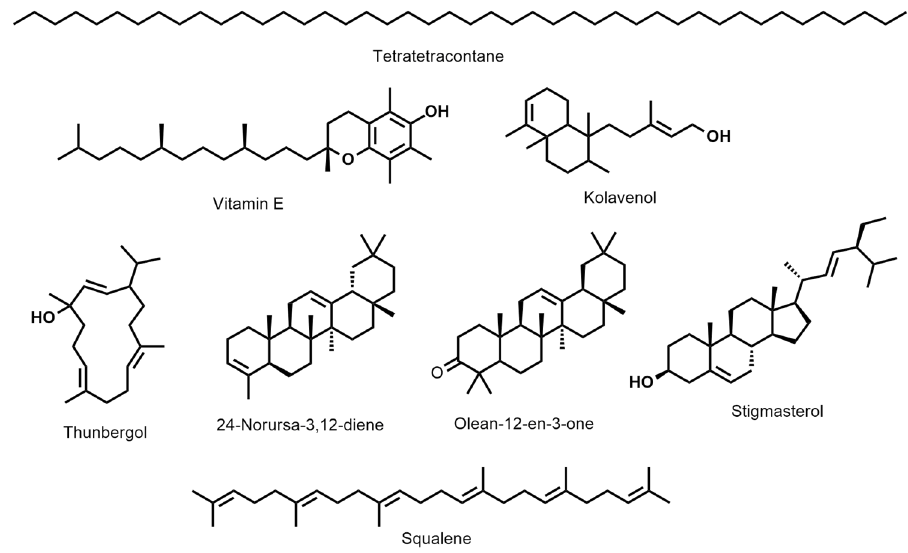
Figure 2. The structures of the major metabolites present in the hexane-extracted leaf oils in D. erecta: ‘Green’, ‘Golden egde’, and ‘Variegata’.